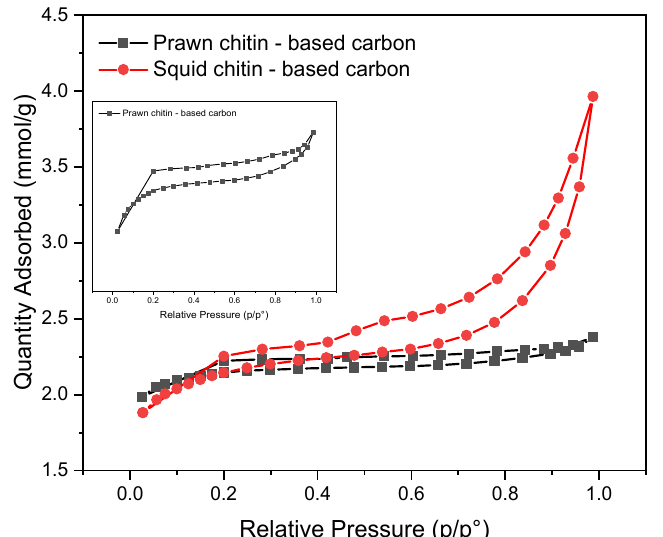
Figure 8. N 2 adsorption–desorption isotherms for prawn and squid chitin-based carbons carbonized for 1 h at 1000 °C.